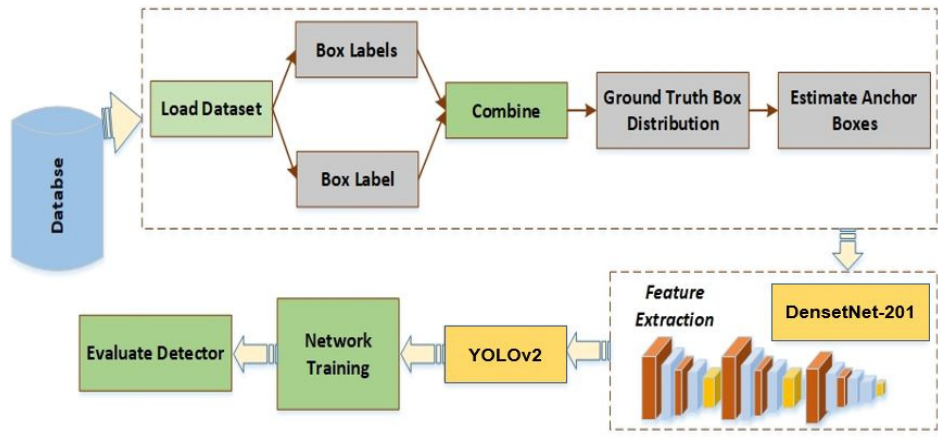
Figure 5. The overall structure of the proposed model.